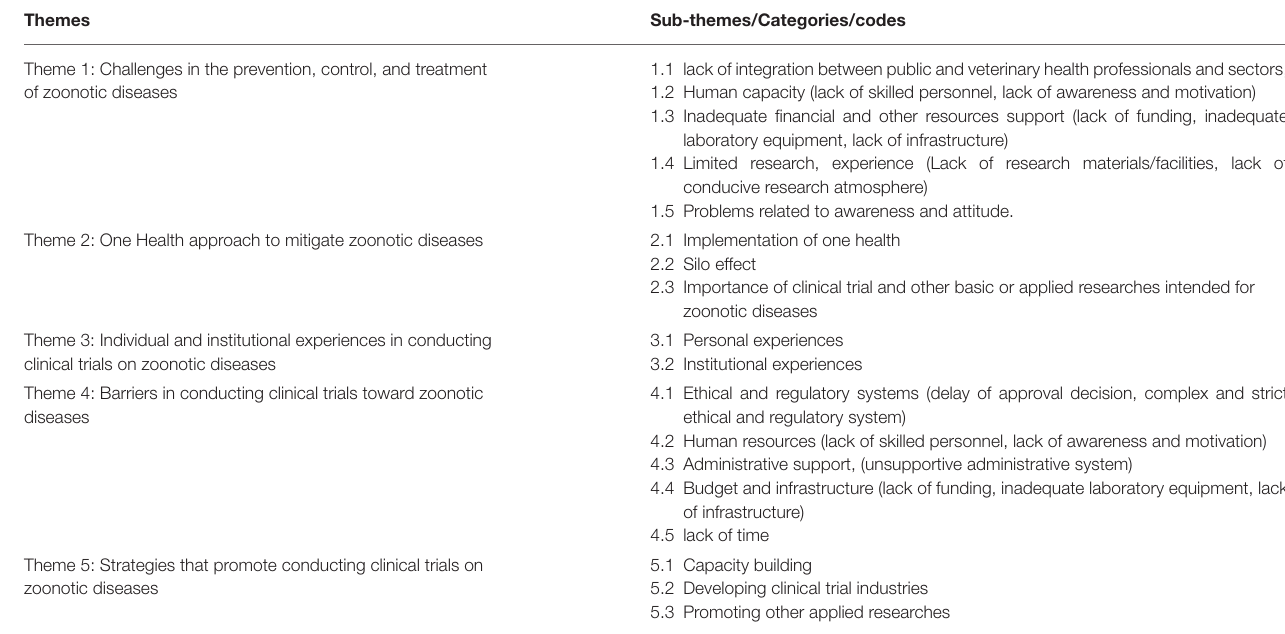
TABLE 2 | List of the themes and sub-themes (codes) that resulted from the data analysis.